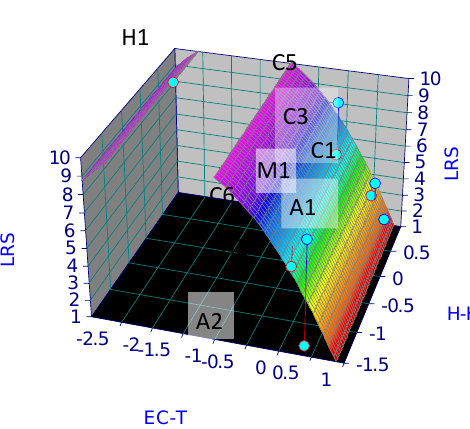
Figure 4. Stygofauna surface resilience (SSR) map: r 2 = 0.63, fitted standard LRS error = 2.1, signifi- cance level F stat = 5.1.